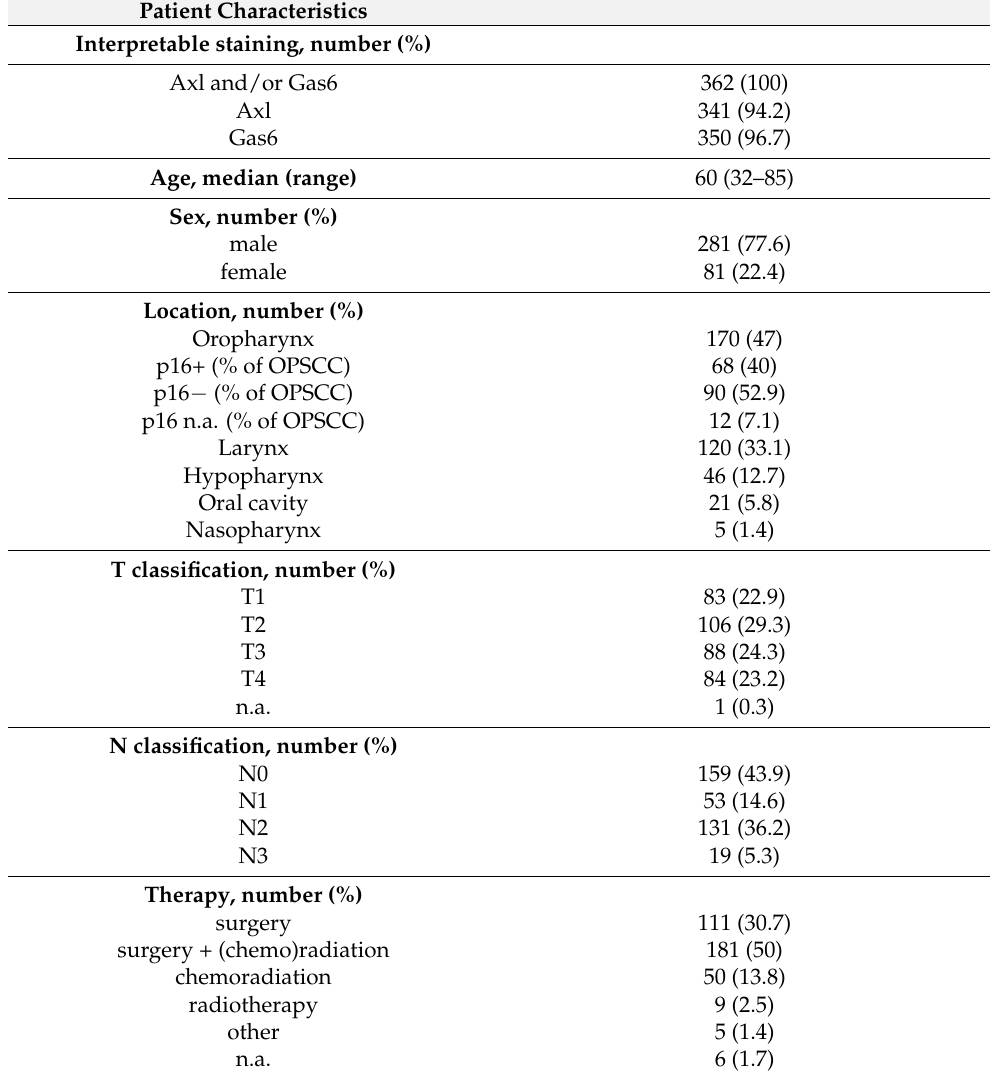
Table 1. Clinicopathological characteristics of patient samples. T- and N-classification were per- formed according the 7th edition of the Union for International Cancer Control (UICC) and represents pathological staging for resected tumors and clinical staging for those treated with definitive RT/RCT. For 12 spots of oropharyngeal tumors, p16 status was not available (n.a.) because of indistinct scoring (intermediate or high staining intensity in ≥ 40 but <70% of tumor cells) or because of a lack of tumor tissue in the p16-stained tissue microarray